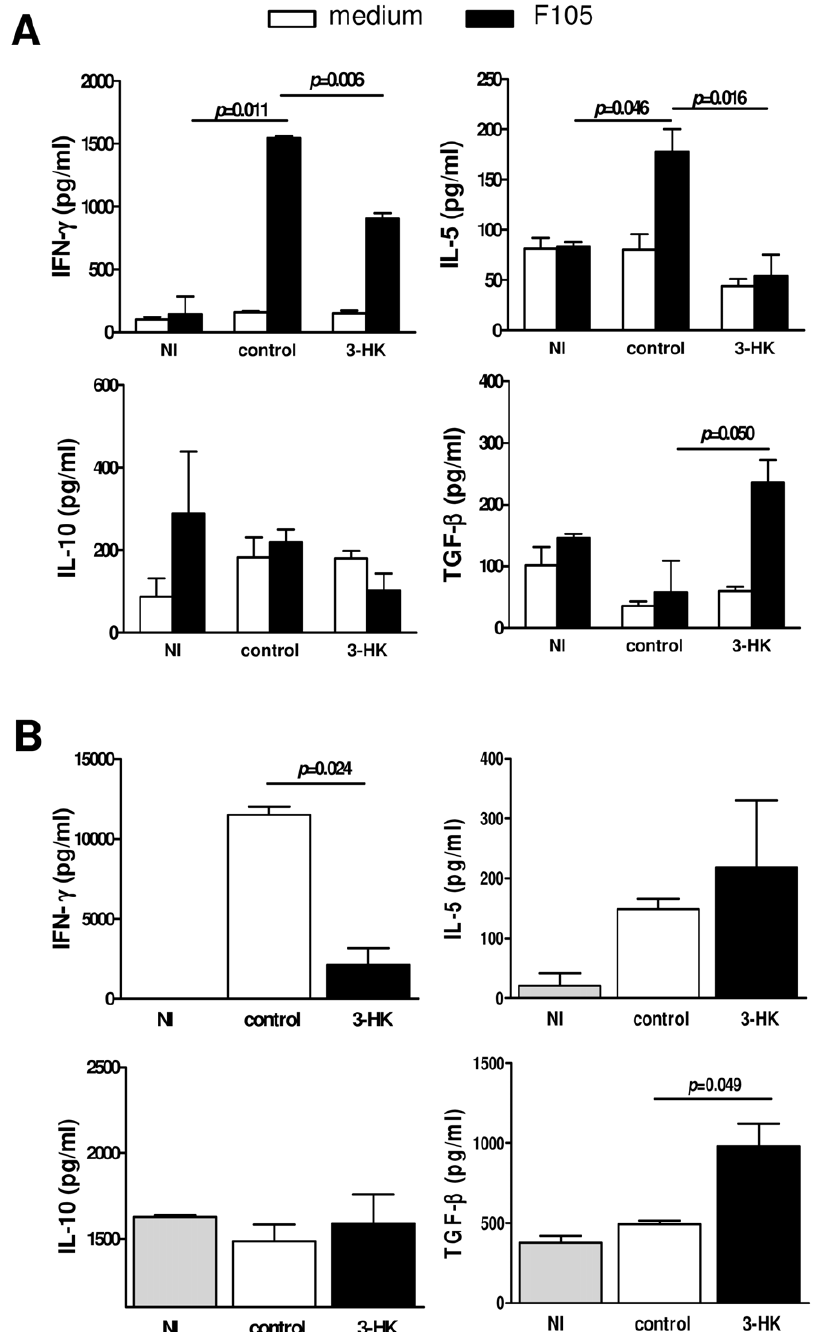
Figure 3. 3-HK treatment modulates T.cruzi specific immune response during the acute phase of infection. (A) SMC from non-infected (NI) mice, 3-HK (n=4) or control (n=4) mice isolated at 16 dpi or from were cultured with or without 15 m g/ml of F105. After 72 h, supernatants were collected and the levels of secreted IFN c , IL-5, IL-10 and TGF- b determined by ELISA. Bars represent the mean values 6 SD from 4 mice/group. These results are from one of three similar experiments, all of which gave similar data. (B) Plasma IFN- c , IL-5, IL-10 and TGF- b concentration in 3-HK (n=4) and control (n=4) 16-day T. cruzi- infected mice or non-infected (NI) mice. Data are shown as mean 6 SD, n=4 mice per group.